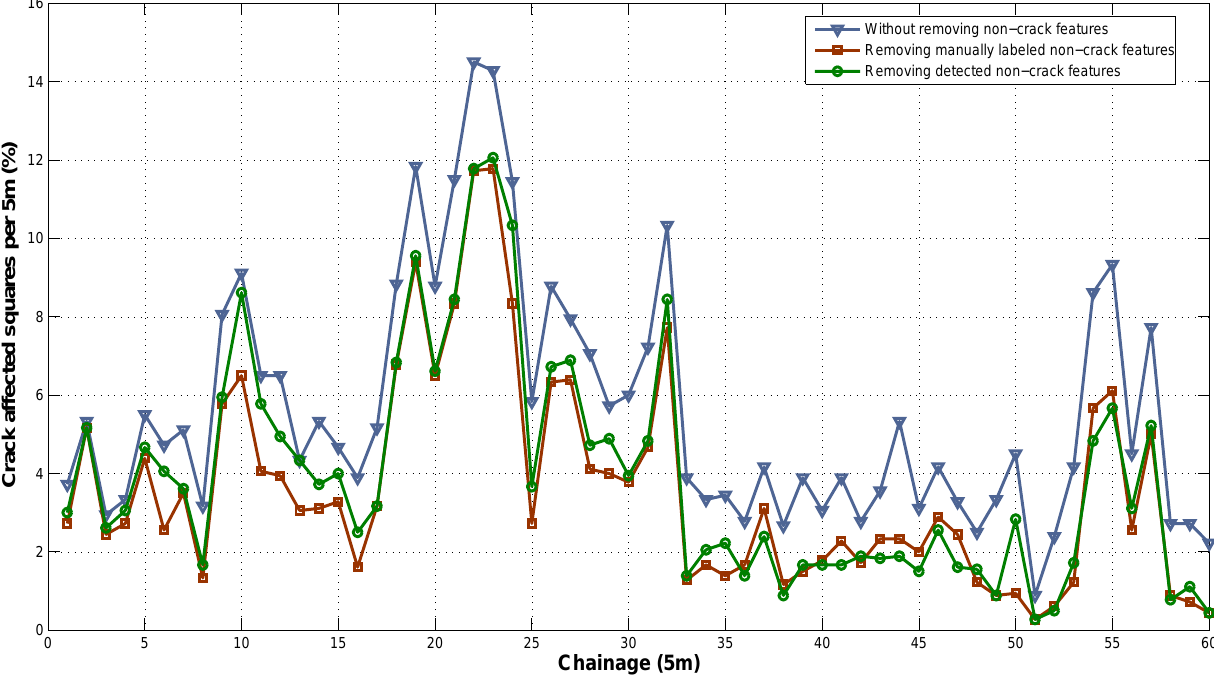
Figure 21. Computed percentage of each 5 m subsection of road affected by cracking, without removing non-crack features, removing manually labeled non-crack features and removing non-crack features detected by the